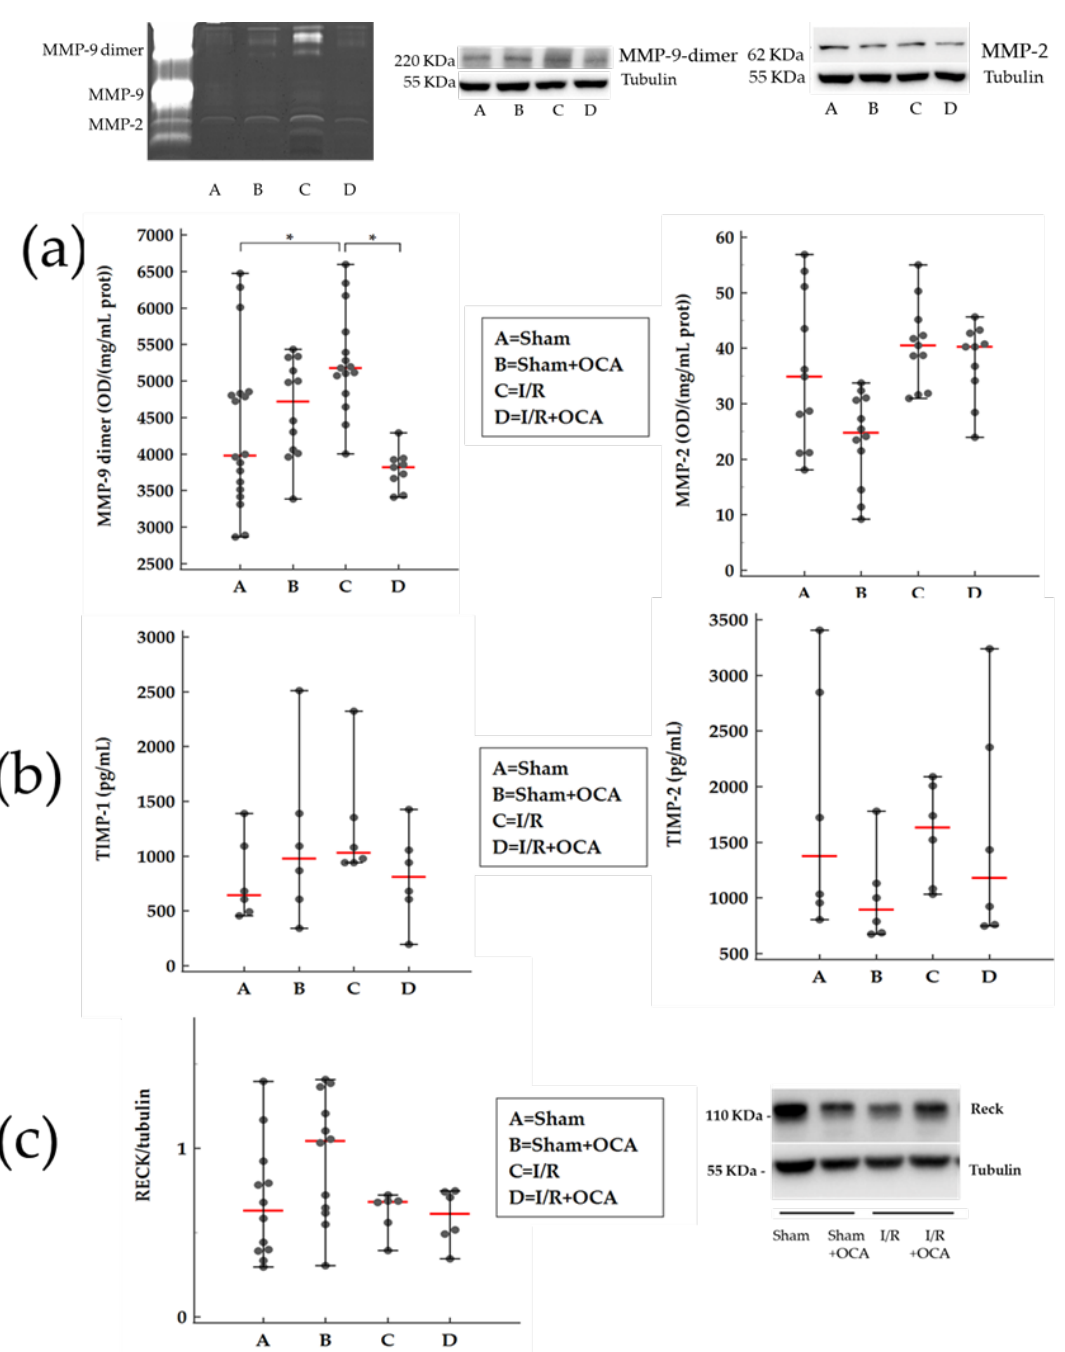
Figure 2. OCA treatment decreases MMP-9-dimer activity in kidney medulla after liver I/R. Animals were orally administered 10 mg/kg/day of OCA in methylcellulose 1% vehicle for 5 days ( n = 12) or vehicle alone ( n = 12). ( a ) Representative of MMP zymography and Western blot; gelatinolytic activities of MMP (MMP-9-dimer and MMP-2) quantified by densitometry. ( b ) TIMPs (TIMP-1 and TIMP-2) by Elisa kits and ( c ) RECK expression levels, by Western Blots, were determined in kidney cortex of rats submitted to partial liver ischemia (60 min) followed by reperfusion (120 min). Sham-operated animals were subjected to the same procedure without clamping the vessels. n = 6 rats/group. Results are expressed as median value (red line) ± error bar (1–99 percentiles) (black dot). one-way ANOVA with Tukey–Kramer test (MMP-9-dimer, MMP-2, and TIMP-1); Kruskal– Wallis test with Conover test (TIMP-2 and RECK). * p < 0.05 versus I/R rats.